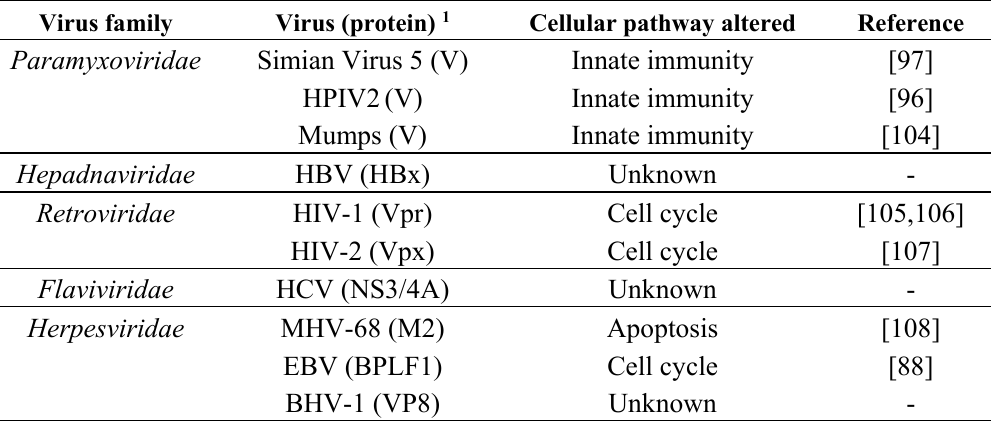
Table 1. Viral proteins that bind